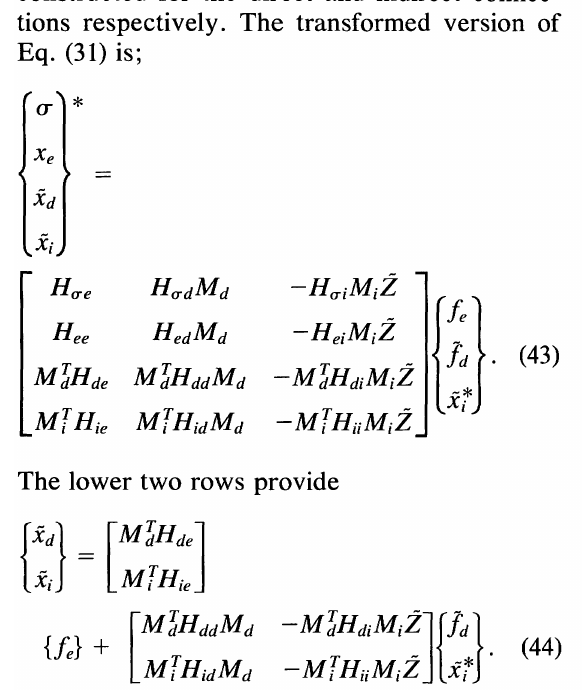
FIGURE 2 Idealized submarine hull model.